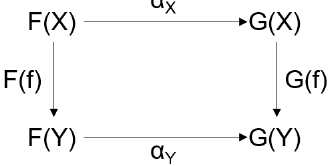
Figure 2. Illustration of a natural